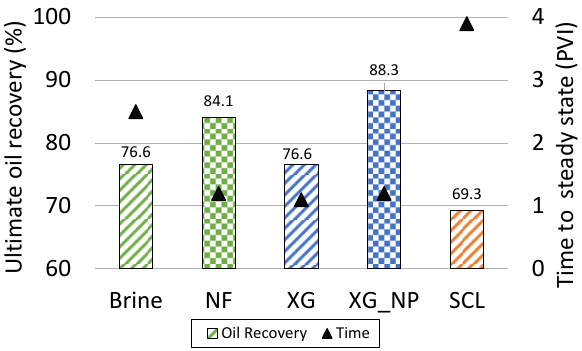
Figure 9. Ultimate oil recovery factor for the solutions evaluated using microfluidic tests as a function of the time to reach the